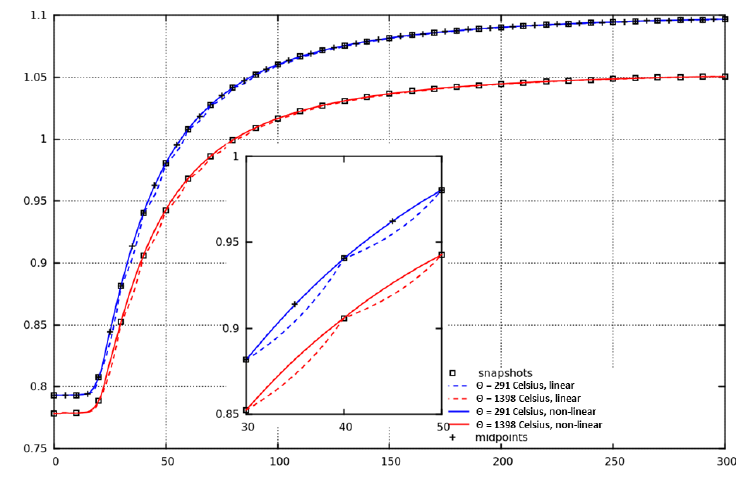
Figure 6. k eff against control-rod height. The dotted line corresponds to the reduced-order model results (GPOD) using the linear interpolation, and the solid line corresponds to the nonlinear interpo- lation. Two uniform temperature fields are used. For comparison, high-fidelity model results are shown, with the snapshots and midpoints (used in the nonlinear interpolation).